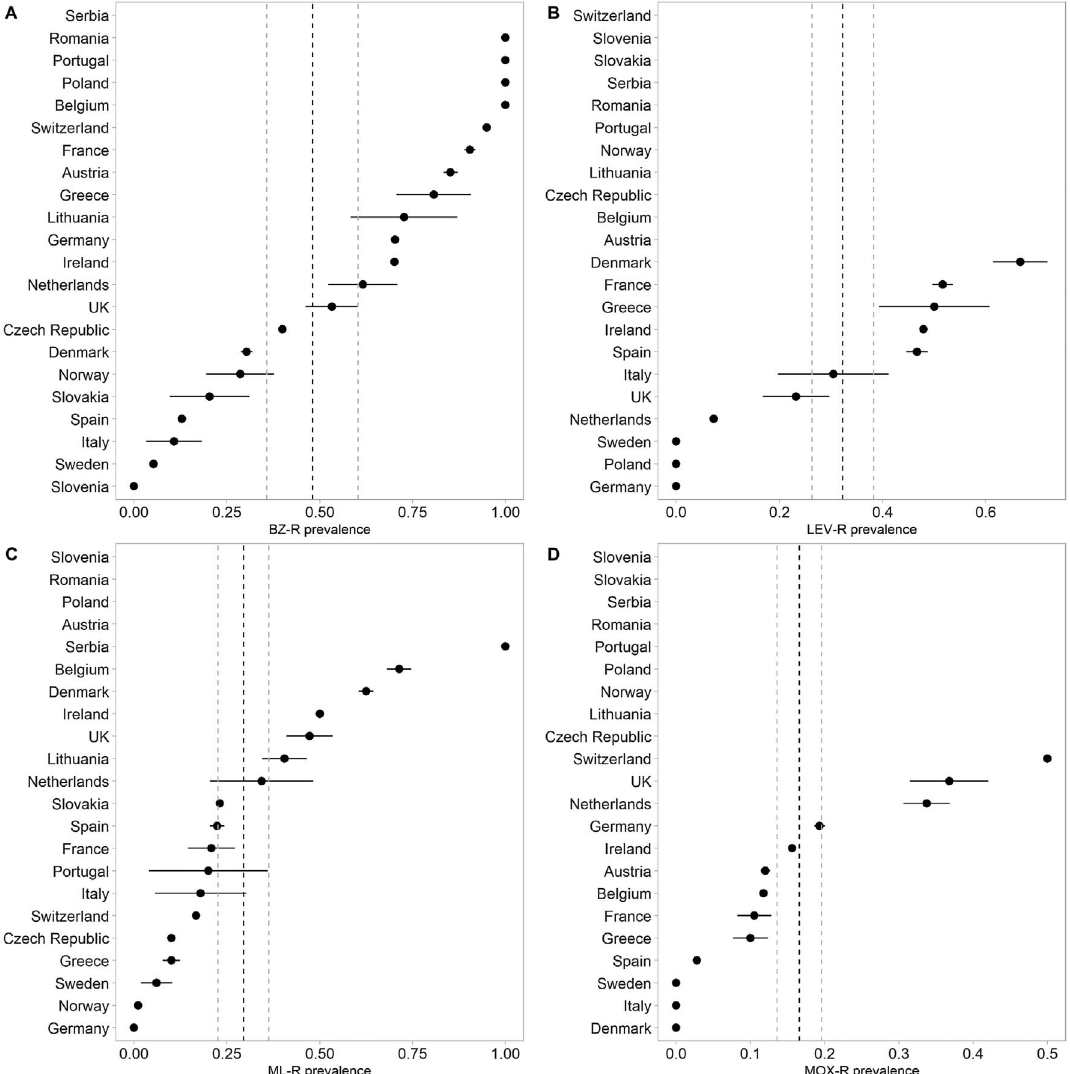
Figure 3. Estimated prevalence of resistance against the benzimidazoles (BZ), levamisole (LEV), avermectins (ML; macrocyclic lactones), and moxidectin (MOX) in gastrointestinal nematodes in sheep. Points and whiskers represent the weighted prevalence estimate and standard deviation, respectively. The weighted prevalence and standard deviation across all studies are represented by the dashed black and grey vertical lines, respectively. Note that points without whiskers represent single studies, for which standard deviations could not be estimated (i.e. they do not represent points which the prevalence is known with a high level of con fi dence). Corresponding fi gures for goats and cattle, and for sheep, goats and cattle using only studies with n > 9 can be found in the Supplementary